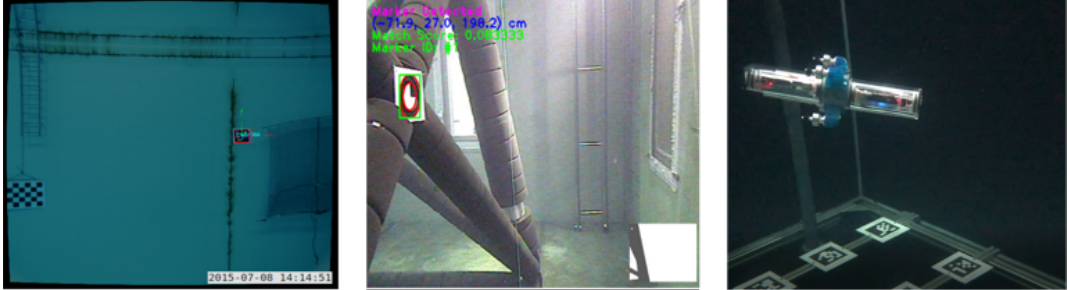
Figure 5. Example works using Augmented reality (AR) markers for underwater localisation, [85] ( left ), [86] ( center ), HippoCampus µ AUV [82] ( right